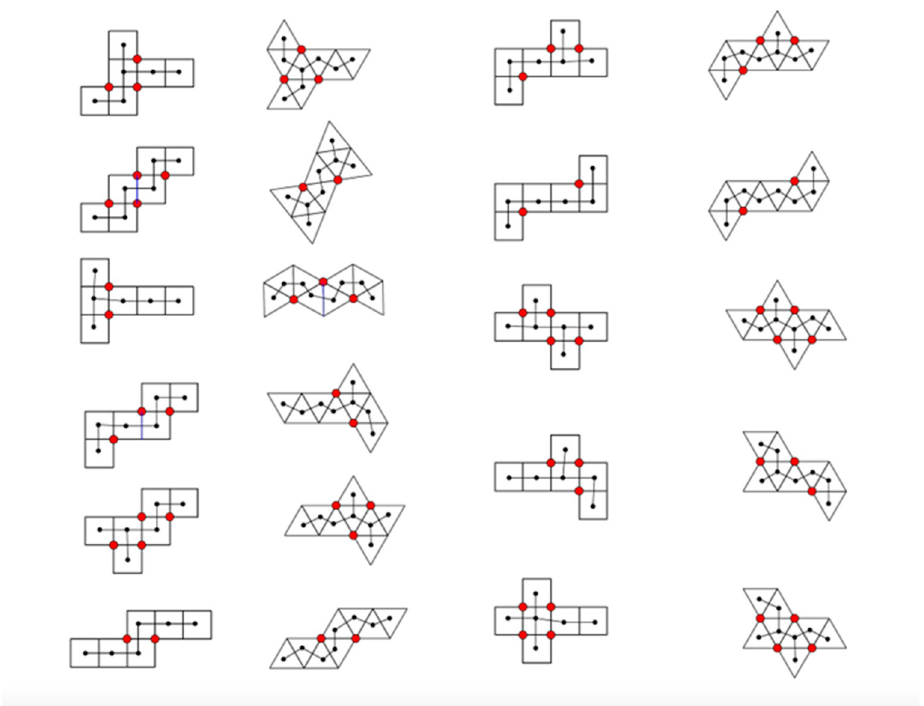
Figure 17. We have redrawn the 11 Dürer nets of cubes and octahedra studied by Dodd, Damasceno, and Glotzer [29] to highlight the position (red) and number vertex connections. We also have added a spanning tree of the centroids of each face.